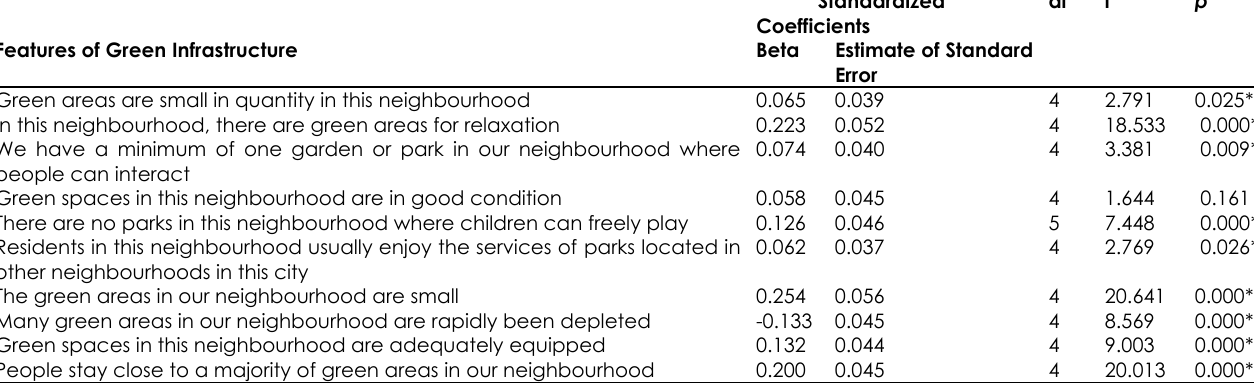
Table 4. Regression analysis of Green Infrastructure features on the endorsement of the NEP.